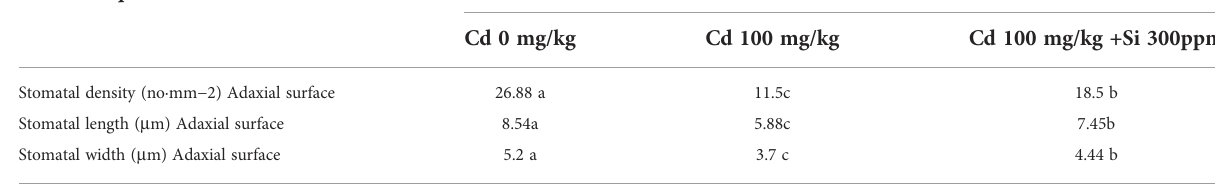
TABLE 8 Effect of foliar application of silicon on number of stomata and size of stomata guard cell grown in different concentrations of cadmium. Stomatal